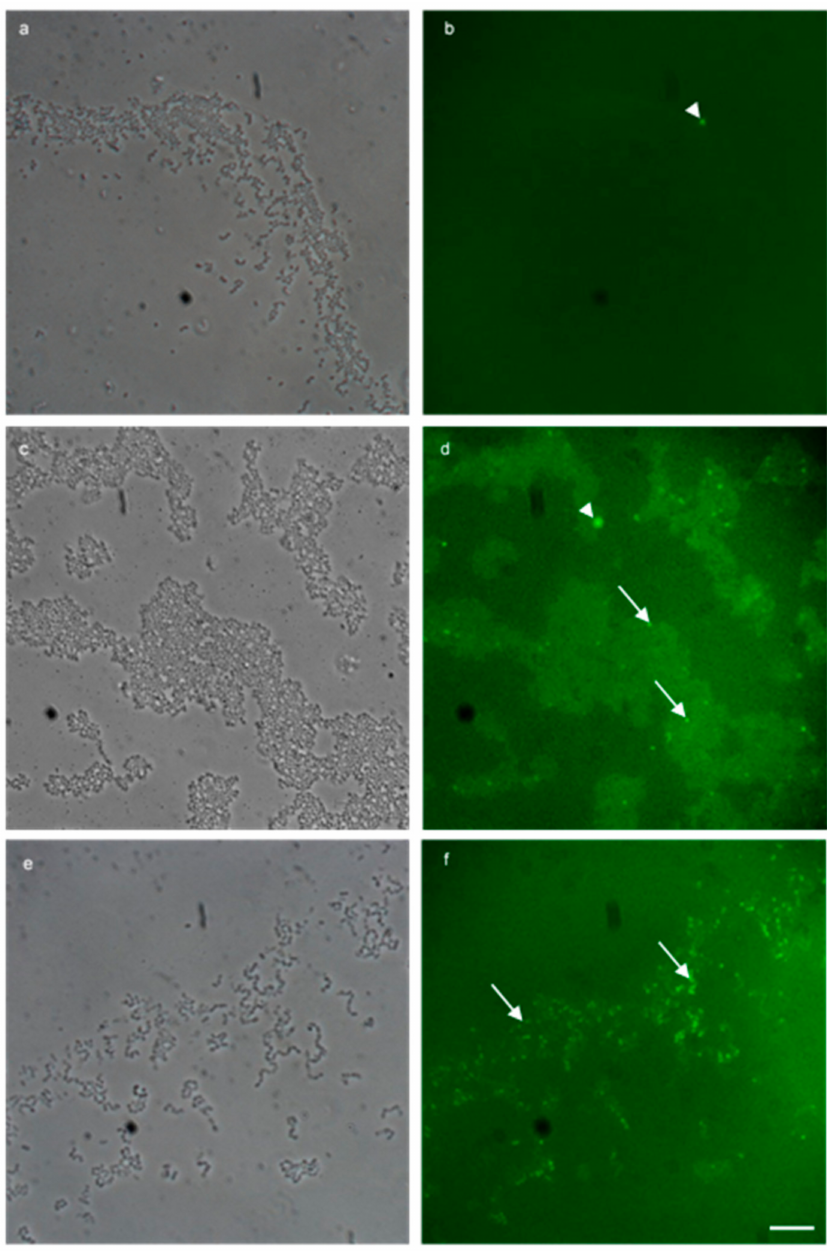
Figure 4. Multi-probe FISH successfully detected plasmid bound van A fluorescein (green) resistance genes in enterococcal biofilm. ( a , b ) 100 × micrograph overlays of a negative biological control using MF04010 and fluorescein probes targeted to the vanA vancomycin resistance gene. ( a ) Phase contrast imaging to highlight MF04010, 48-h biofilm cells grown with TSB (1% glucose) at 37 ◦ C incubated statically. Media was replaced at the 24-h time point. ( b ) Green fluorescent imaging of the same region. ( c , d ) 100 × micrograph overlays of the addition of sub inhibitory (10 µ g/mL) vancomycin for 34 h, to the vanA positive MF06036 in a 24-h pre-established biofilm grown with TSB (1% glucose) at 37 ◦ C. ( c ) Phase contrast imaging MF06036 vancomycin exposed biofilm. ( d ) Green fluorescent imaging of the same region. ( e , f ) 100 × micrograph overlays of the addition of sub inhibitory (10 µ g/mL) vancomycin to the biofilm formation media TSB (1% glucose) during the formation of isolate MF06036 (cid:48) s biofilm (24 h). Media was replaced at the 24-h time point with vancomycin TSB (1% glucose) for an additional 24 h. ( e ) Phase contrast imaging MF06036 vancomycin exposed biofilm. ( f ) Green fluorescent imaging of the same region. Scale bar represents ten microns. Arrowhead— fluorescence artefact, arrow—cell positive for vanA